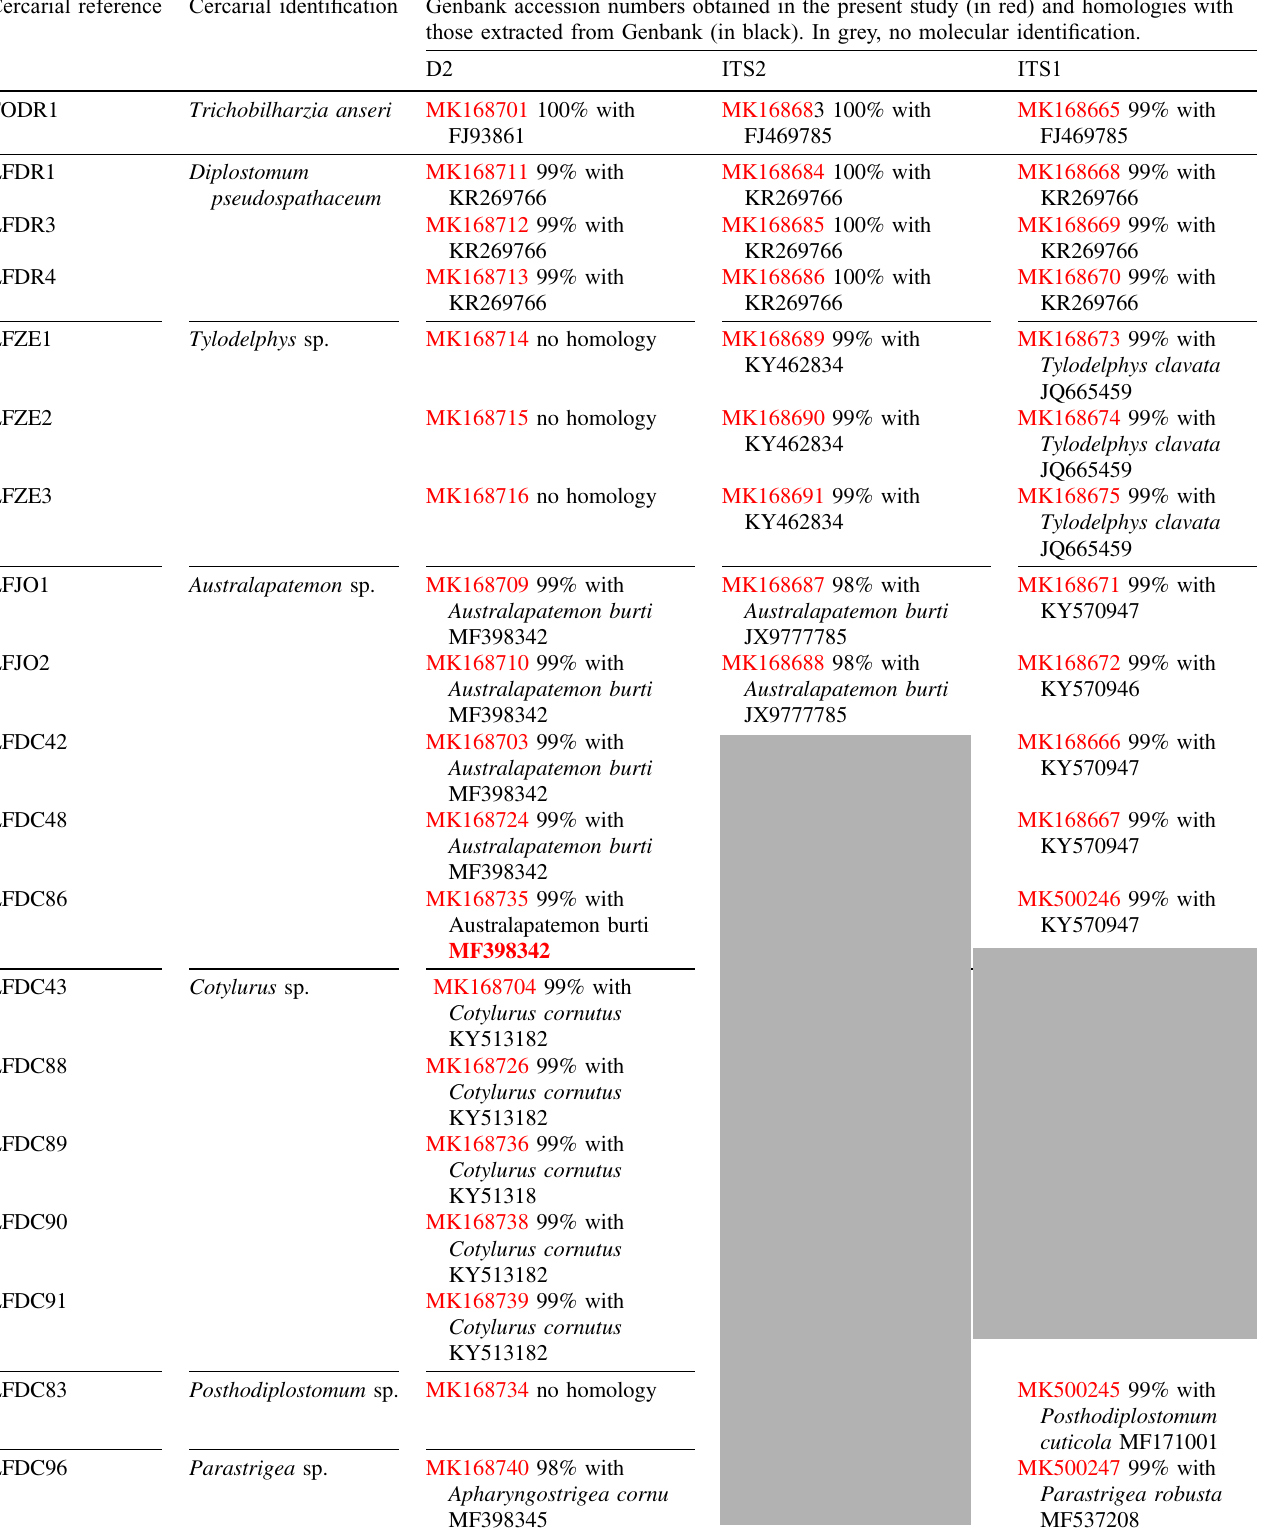
Table 2. Molecular identi fi cation of processed cercariae. Cercarial reference Genbank accession numbers obtained in the present study (in red) and homologies with those extracted from Genbank (in black). In grey, no molecular